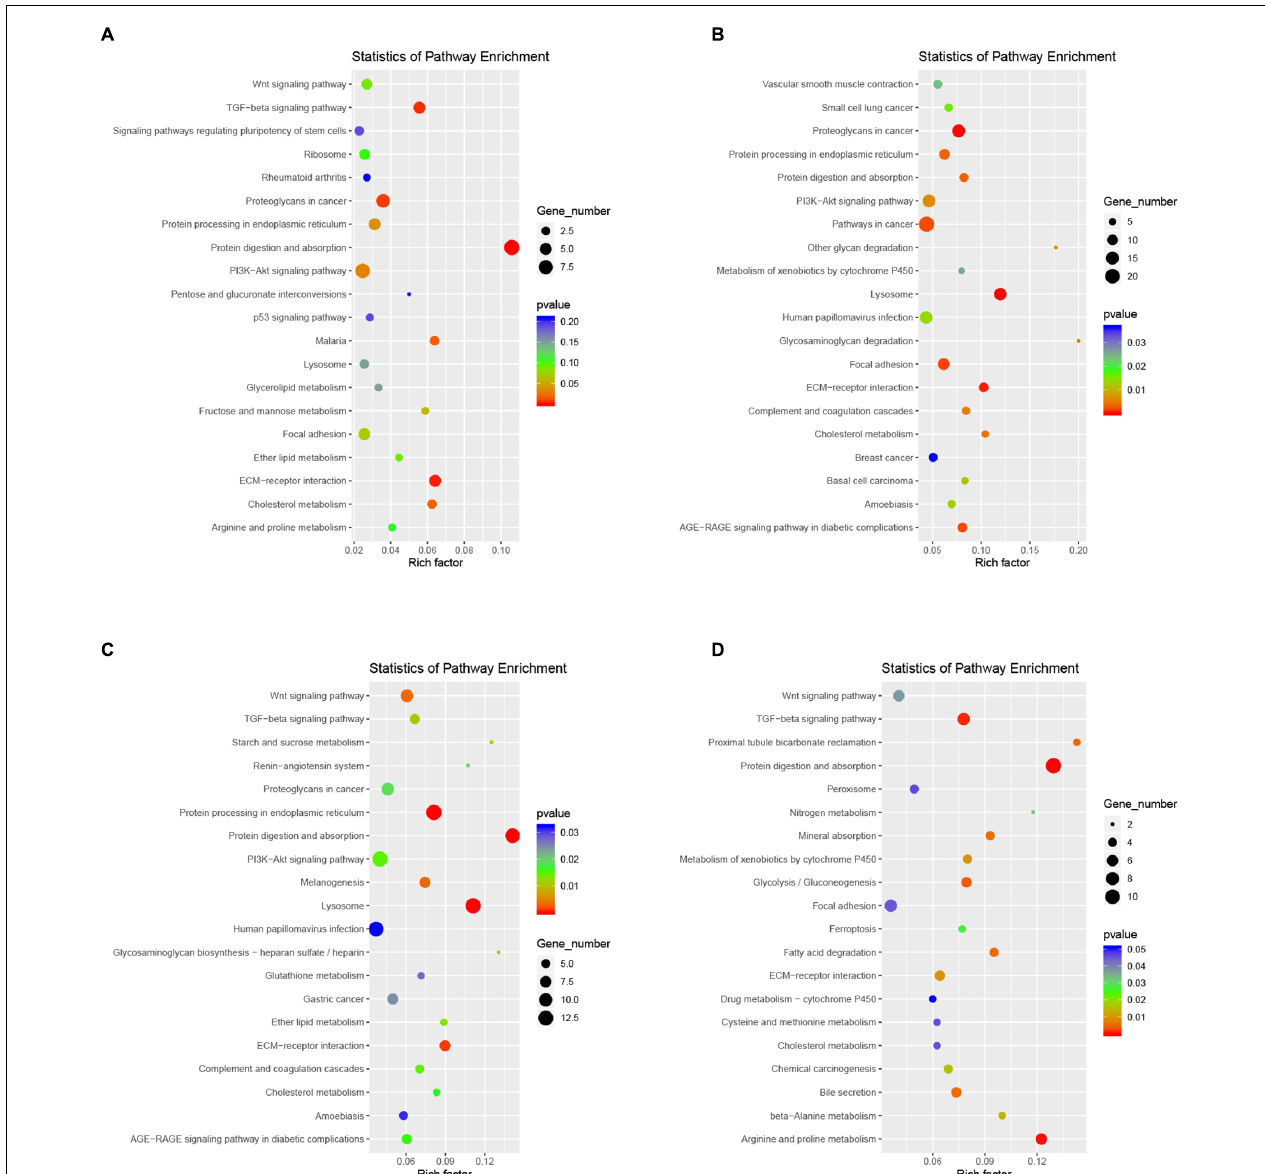
FIGURE 11 | Functional enrichment analyses using KEGG pathways for cluster 2 (A) , cluster 7 (B) , cluster 9 (C) , cluster 12 (D) . The cycle size indicates the corresponding significance values displayed as log10 ( P -value). The much bigger the triangle size, the much more genes enriched in this